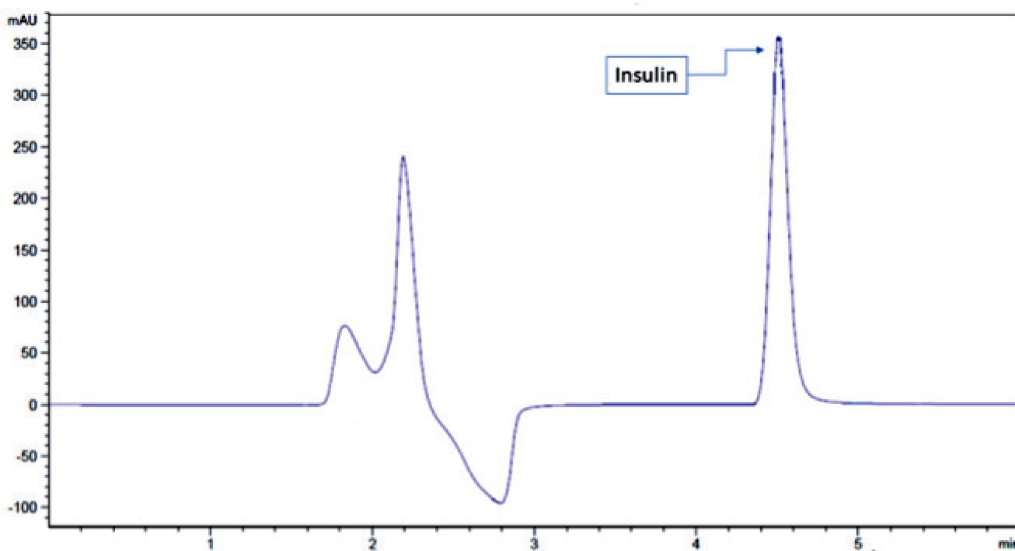
Figure 1 . Representative chromatogram of insulin reference substance. Conditions: mixture of acetonitrile and 0.1% TFA aqueous solution (60:40,v/v) as mobile phase, flow rate at 1.0 mL/min, column temperature 25 ± 1 °C, RP C18- Luna ® Phenomenex (4.6 × 250 mm, 5 μm particle size) column, UV detection wavelength at 214 with 20 μL of injection